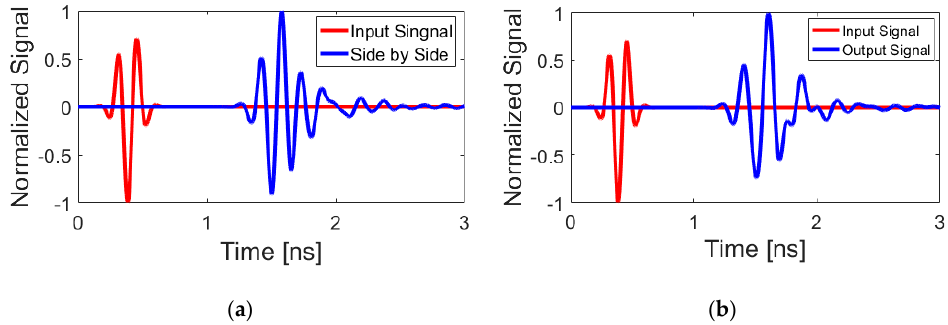
Figure 10. Input/output signal pulses for ( a ) side by side and ( b ) face to face scenarios.